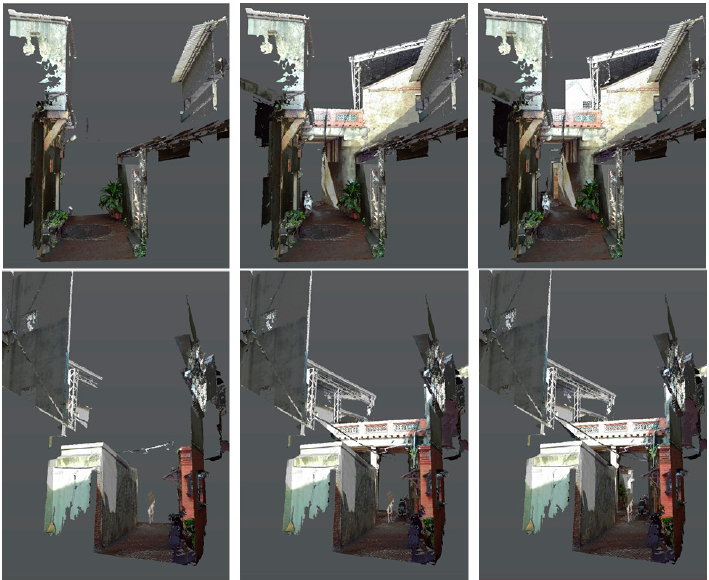
Figure 4. Approaching views of Shih Yih Hall from near to distant ( top ) and from the other direction ( bottom ).